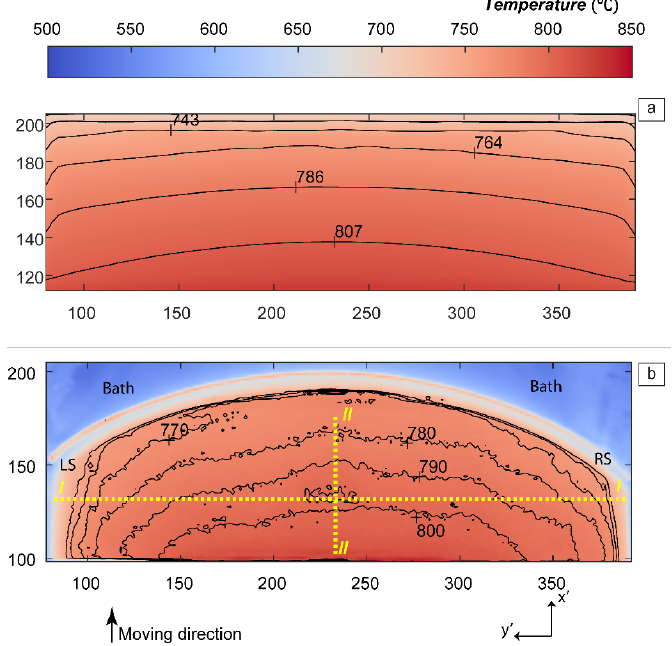
Figure 7. Temperature results ( a ) predicted result from the model and ( b ) measured temperature by the IR-camera in °C, ε = 0.4. Gas inlet position: surface A in Figure 2, 𝑄 = 2.66 Nm 3 /h , strip velocity = 𝑣 𝑆𝑡𝑟𝑖𝑝 (< 0.17 m/s) .